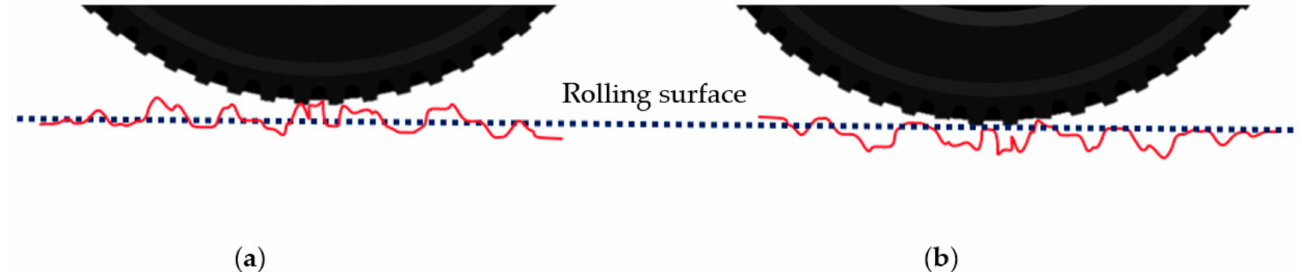
Figure 2. Schematic representation of a positive texture ( a ) and negative texture ( b